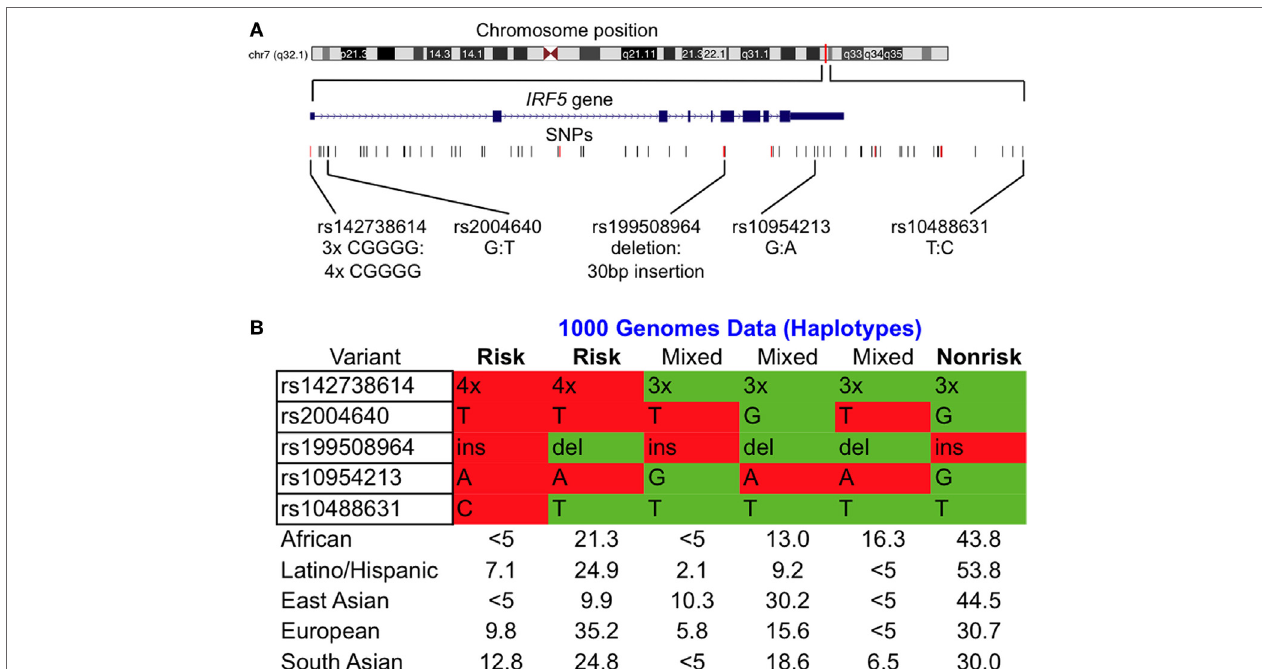
FigUre 1 | Common interferon regulatory factor 5 (IRF5) risk and non-risk haplotypes are present across various populations. (a) Chromosomal location of the IRF5 locus of interest with SNPs considered in our study. Alleles are indicated as non-risk:risk. (B) Condensed haplotypes obtained from 1000 Genomes present in > 5% of the indicated ethnic populations. Those labeled risk and non-risk were included in our study. Abbreviations: ins, insertion; del,